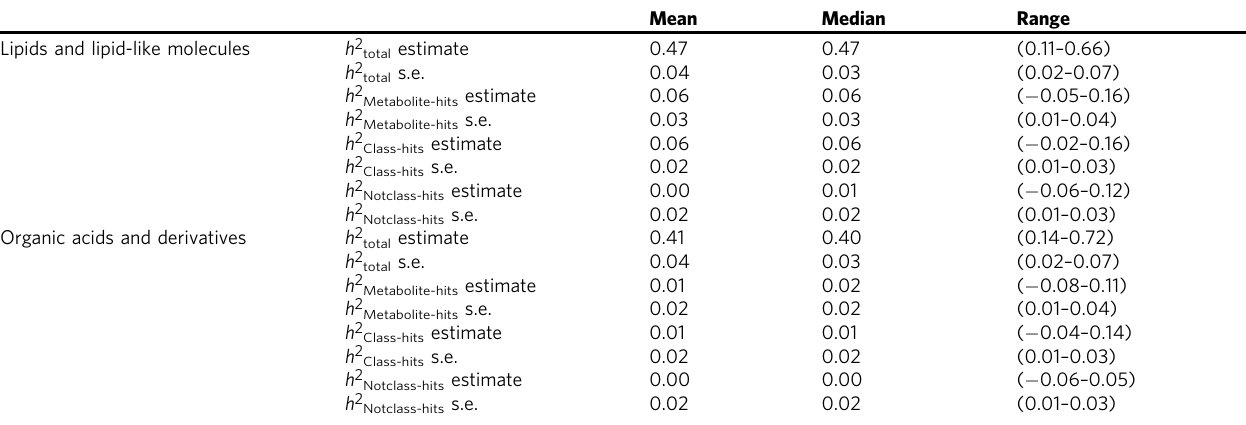
Table 3 Summary of the heritability estimates of the four-variance component